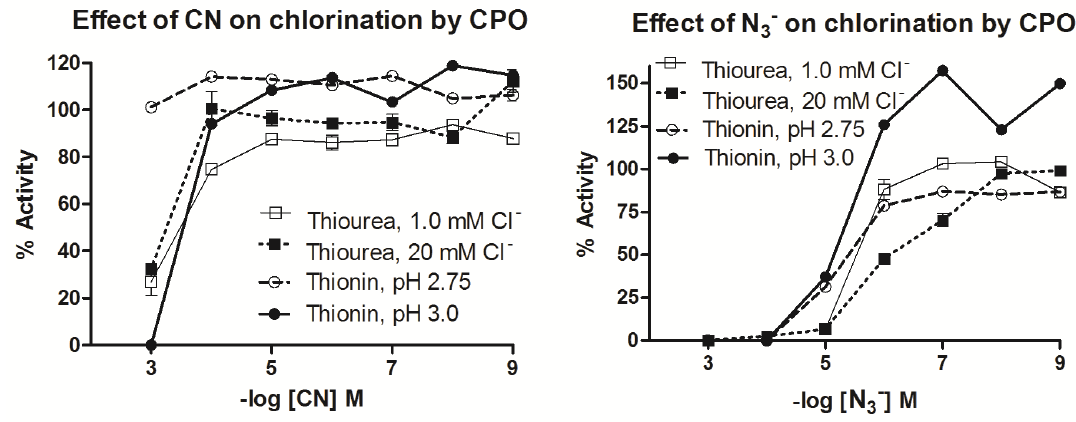
Figure 2: A comparison of activity profiles of CPO mediated bleaching (chlorination) of thionin and thiourea, in the presence of mM to nM levels of CN or N 3- [4]. At lower concentration of CN, a slight activation can be noted in some of the thionin reaction mixtures. Also, an inexplicably lower level of activity is obtained with sub-micromolar ranges of CN in the thiourea reaction, after activity is recovered at supra- micromolar CN, and then again, activity rises above control value at nM CN. In the azide incorporating reactions, the activations are more pronounced at lower concentrations, in the thionin reaction. Azide, a poorer binder of hemeFe (when compared to CN) gave several orders lower IC than CN. Such observations cannot be sponsored by binding based outcomes. (For details of experimental setup, please refer 50 methods